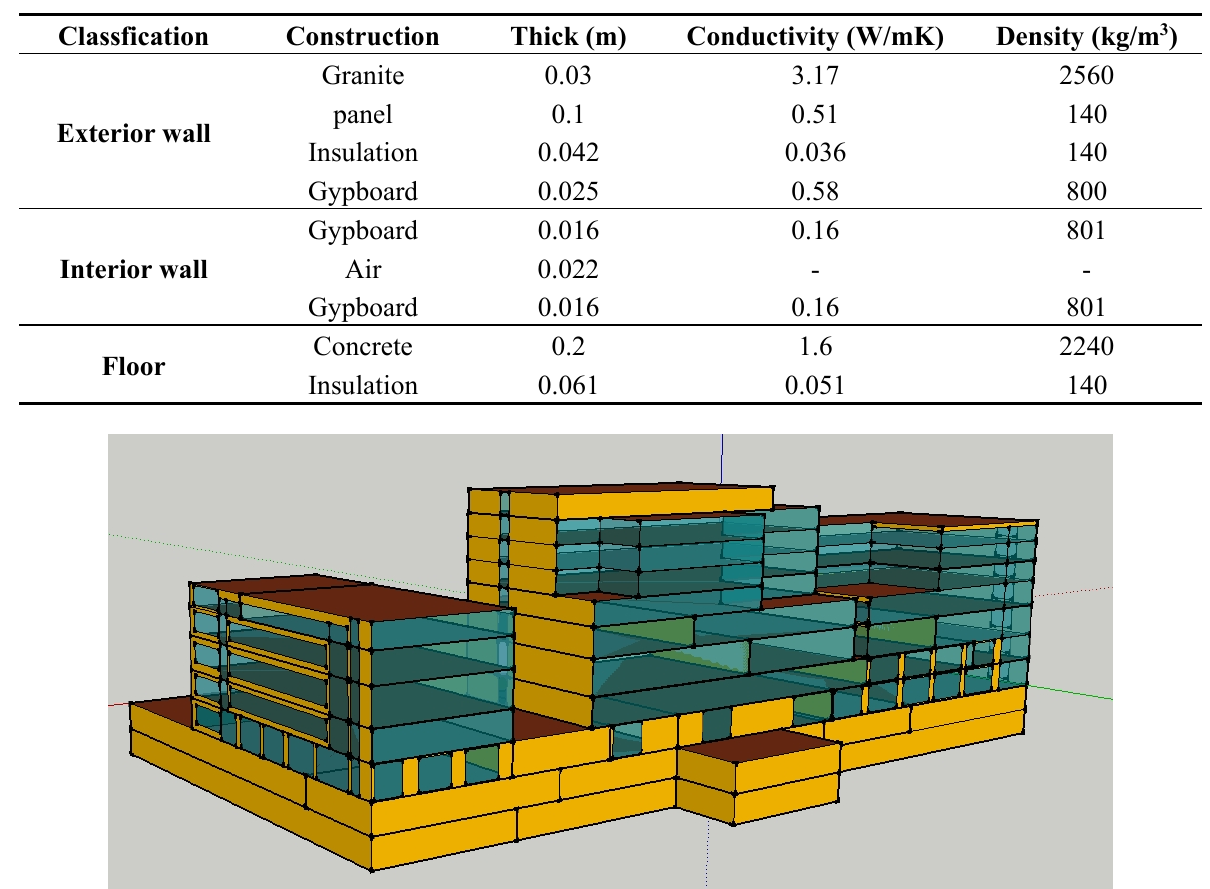
Table 8. Material property specifications.